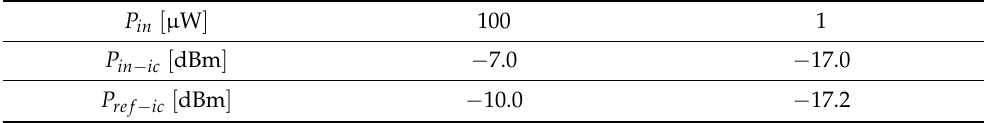
Table 5. Value of P in − ic and P ref − ic for each P in .